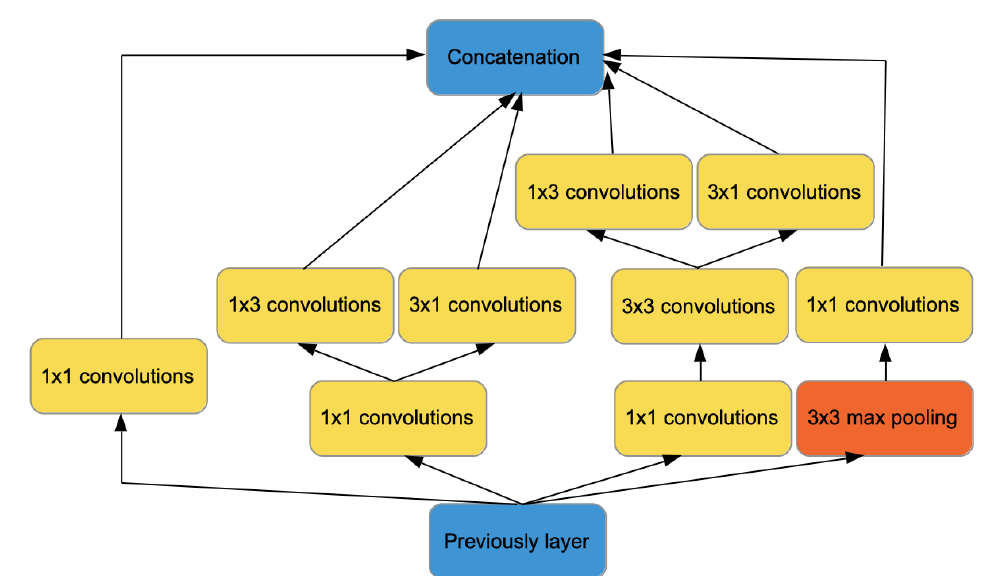
Figure 2. Inception-V2 module is obtained factorizing filters kernel size 5 × 5 to two 3 × 3 and then factorizing n × n convolutions to a stack of 1 × n and n × 1